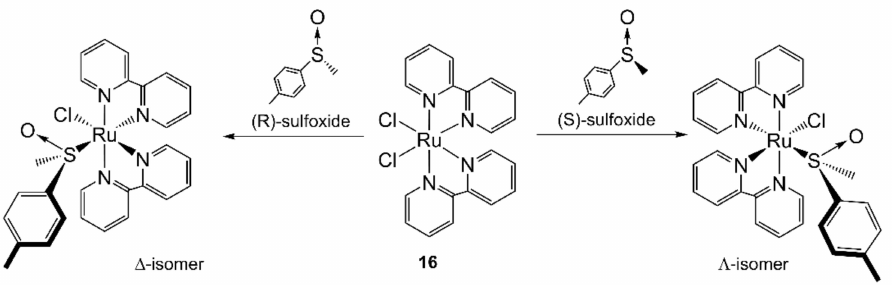
Figure 6. Scheme of the reaction to obtain ruthenium bis( α -diimine) sulfoxide complexes adapted from